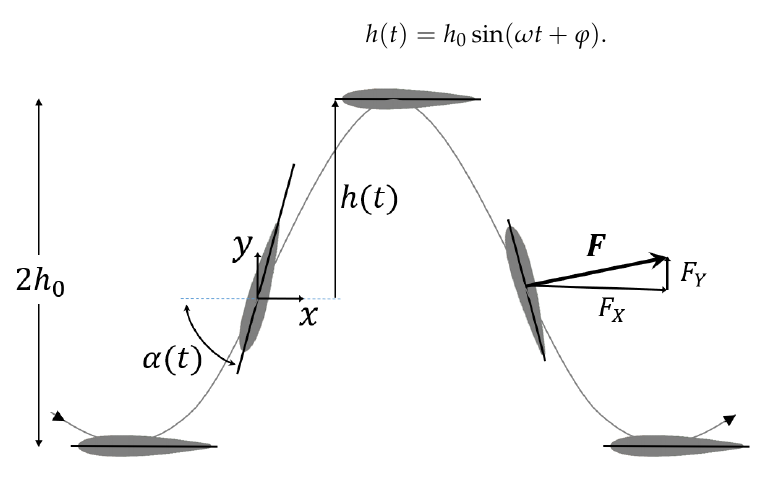
Figure 1. Oscillating hydrofoil in power extraction regime. Both the heaving h ( t ) and the pitching α ( t ) motions are